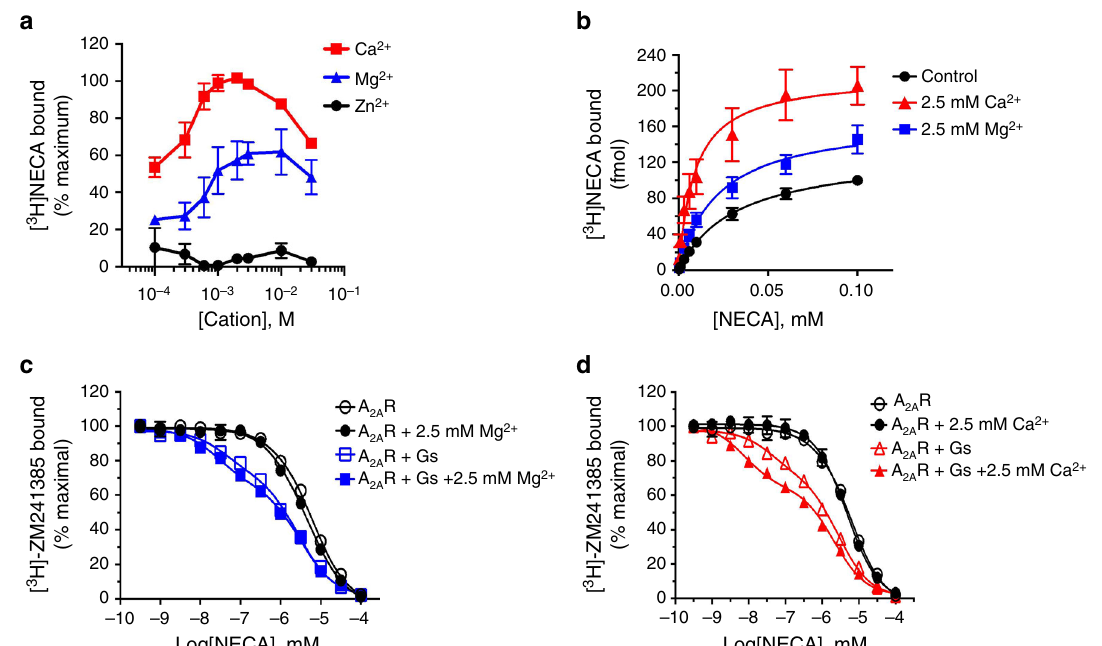
Fig. 4 Radioligand binding assay in A 2A R/G s -infected Sf 9 membranes. a Cations, Mg 2 + or Ca 2 + , enhance speci fi c [ 3 H]NECA binding in A 2A /G s -infected Sf 9 membranes, while Zn 2 + displayed reduced binding. b Speci fi c [ 3 H]NECA high af fi nity saturations ±2.5 mM Ca 2 + or ±2.5 mM Mg 2 + . c Divalent cation, Mg 2 + , enhances the af fi nity of NECA binding and the fraction of high af fi nity binding sites on A 2A R in a G-protein-dependent manner. d Divalent cation, Ca 2 + , enhances the af fi nity of NECA binding and the fraction of high af fi nity binding sites on A 2A R in a G-protein-dependent manner. Error bars for radioligand binding assays are de fi ned based on three replicates